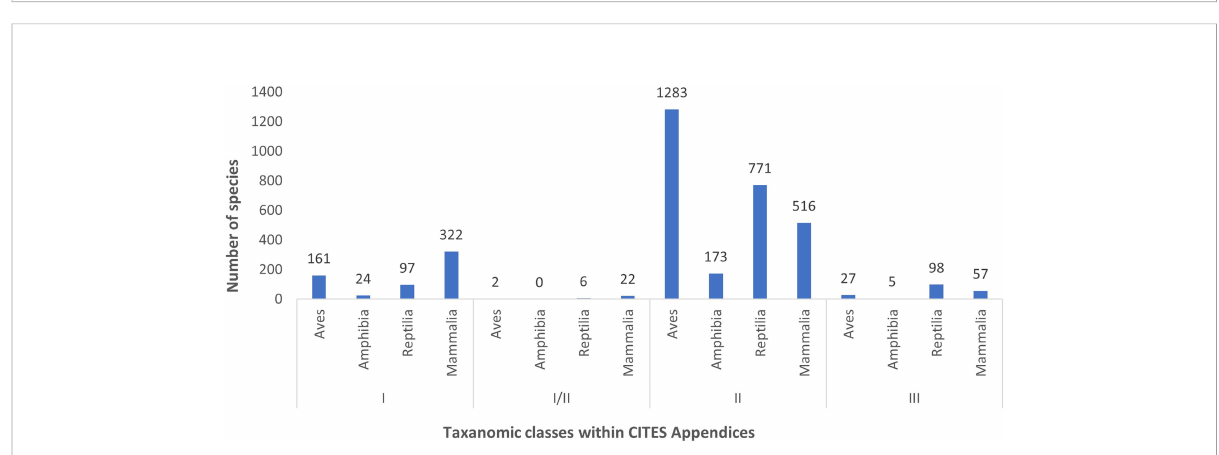
FIGURE 7 Number of species within each of the four classes Aves, Amphibia, Reptilia and Mammalia, listed on Appendix I, Appendix I/II, Appendix II or Appendix III according to the CITES Appendices. N =